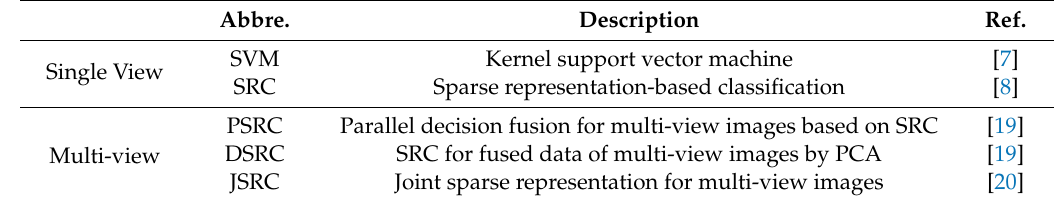
Table 2. The reference methods used in this paper.